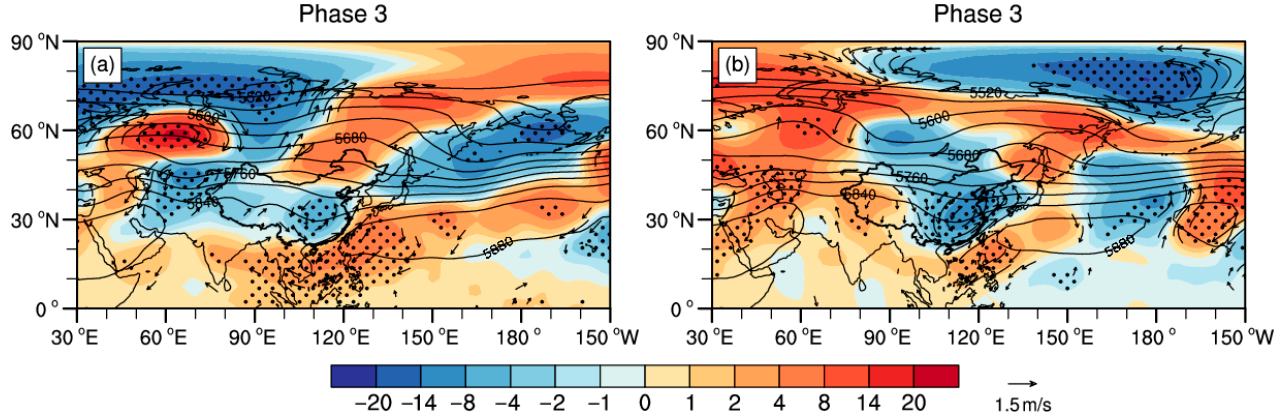
Figure 6. Composite of the 500 hPa height field (shaded: LF component of 10–20 days, gpm, dotted areas are significant at α = 0.1 level; contours: observations, gpm) and LF wind field (vector, m/s, significant at α = 0.1 level) based on the LF precipitation of 10–20 days at the peak of phase 3 ( a , b ) in flood ( a ) and drought ( b ) years.